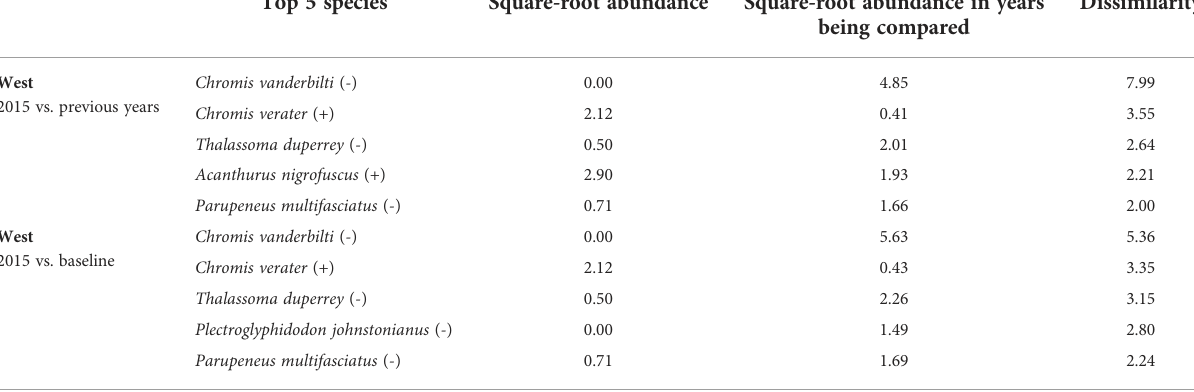
TABLE 6 Results of SIMPER analysis showing the top fi ve species that contributed to separating fi sh assemblages of KALA in 2015 years as identi fi ed by MCCs. Top 5